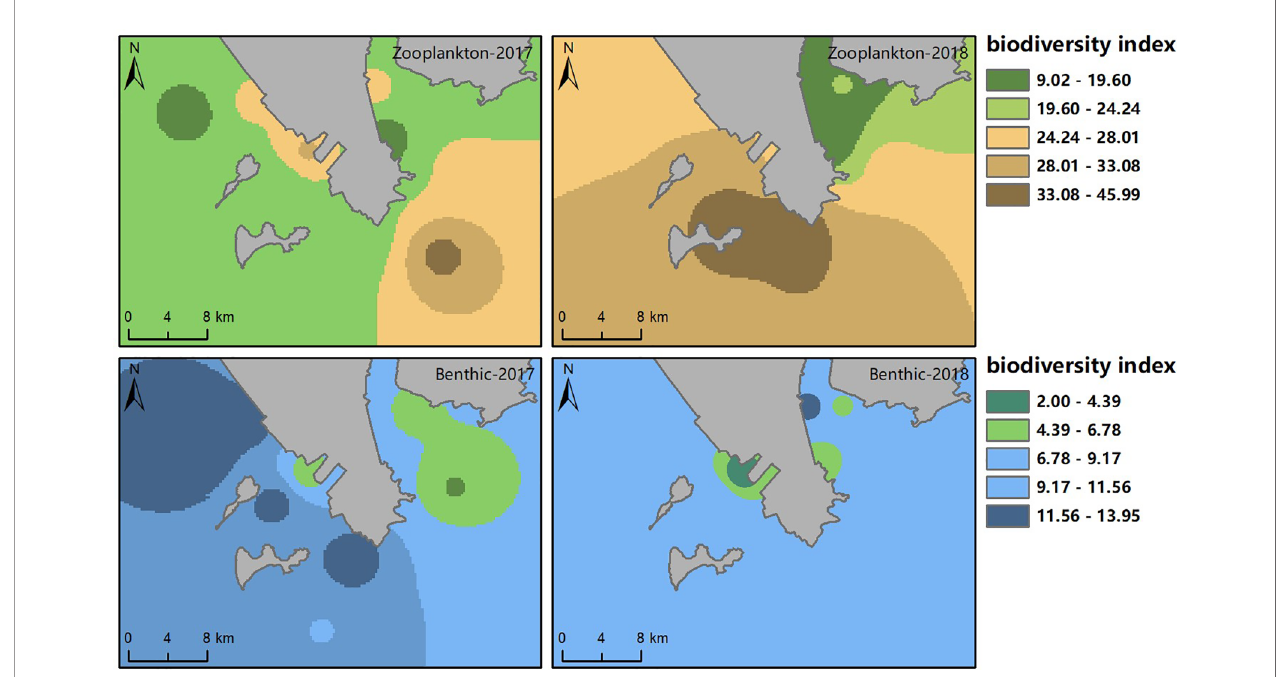
FIGURE 6 | Evaluation results of zooplankton diversity index and benthic biodiversity index in coastal of